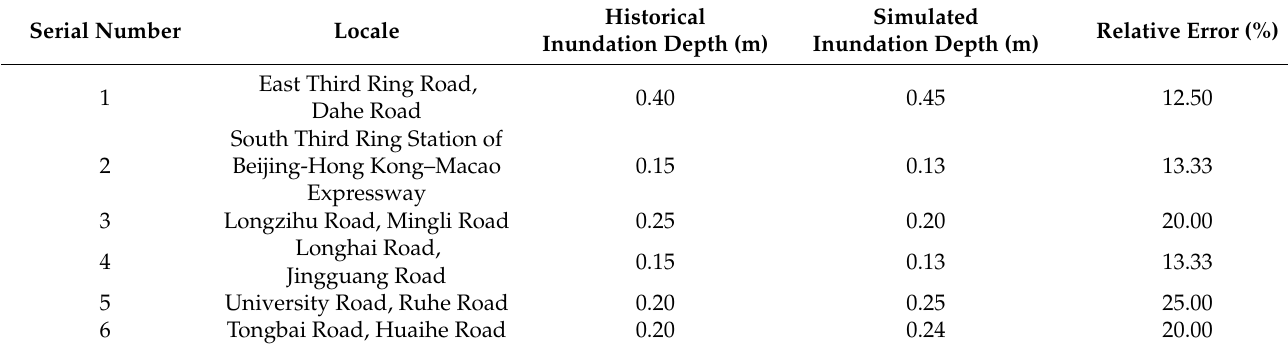
Table 4. Calibration results of rainfall event